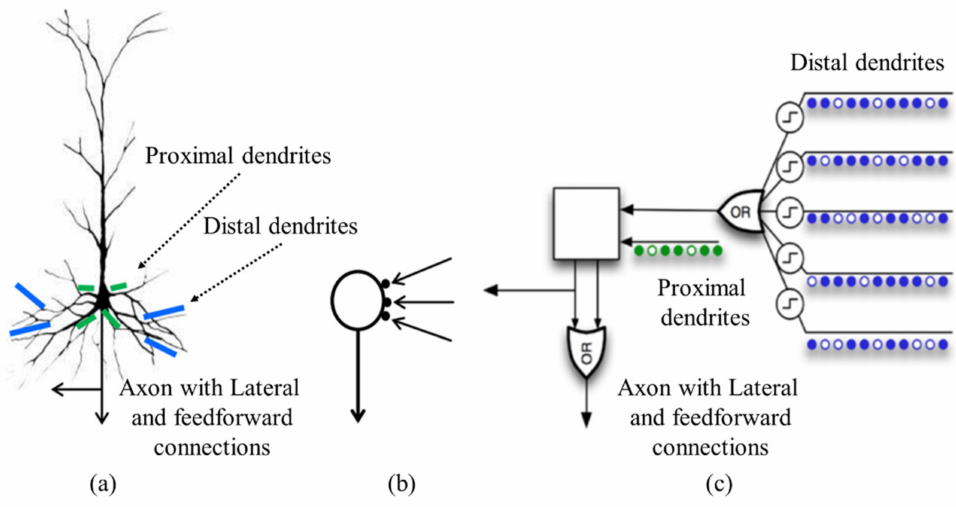
Figure 3. Comparison of ( a ) biological neuron, ( b ) artificial neuron model for the existing neural networks, and ( c ) a neuron cell model in HTM [13].